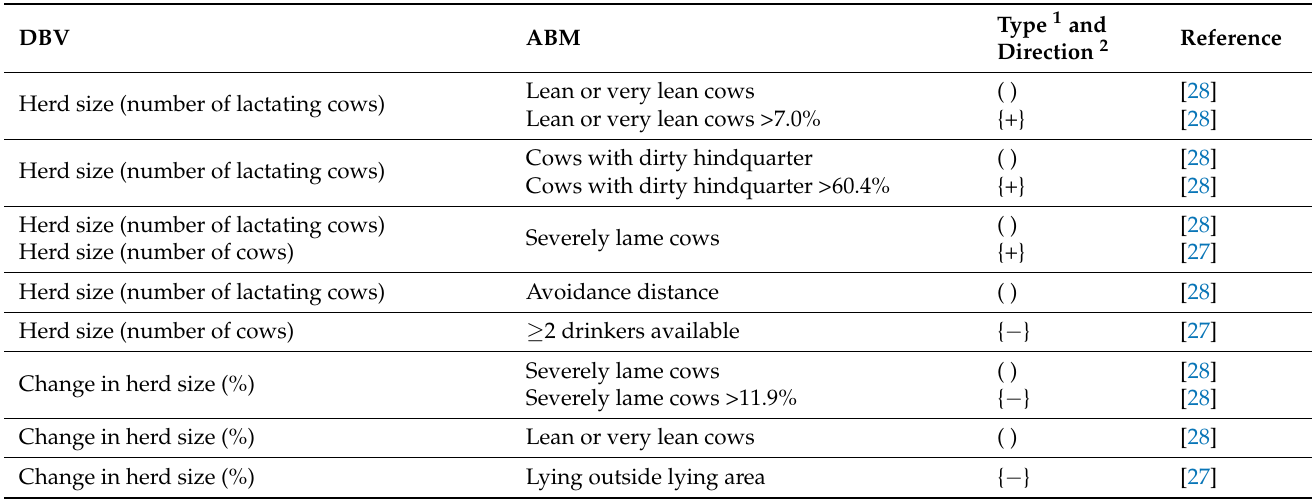
Table 6. Associations between data-based variables (DBVs) related to herd size and animal-based measurements (ABMs) extracted from two scientific publications.